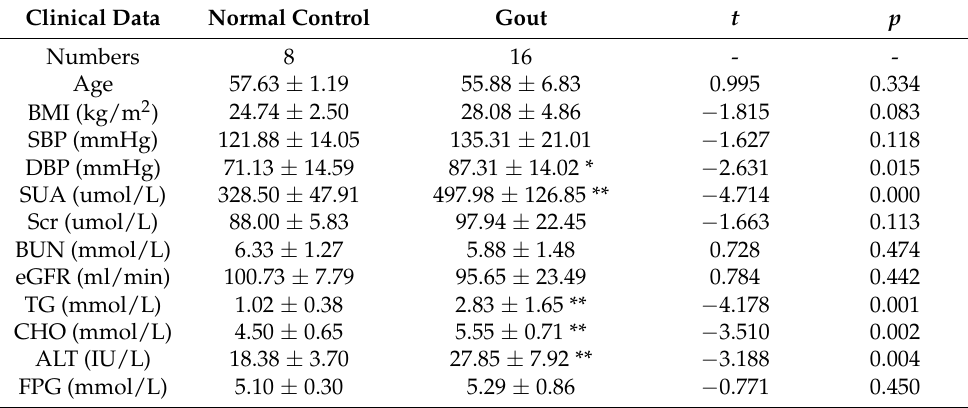
Table 1. Comparison of clinical data between the control group and gout group ( x ± s). Clinical Data